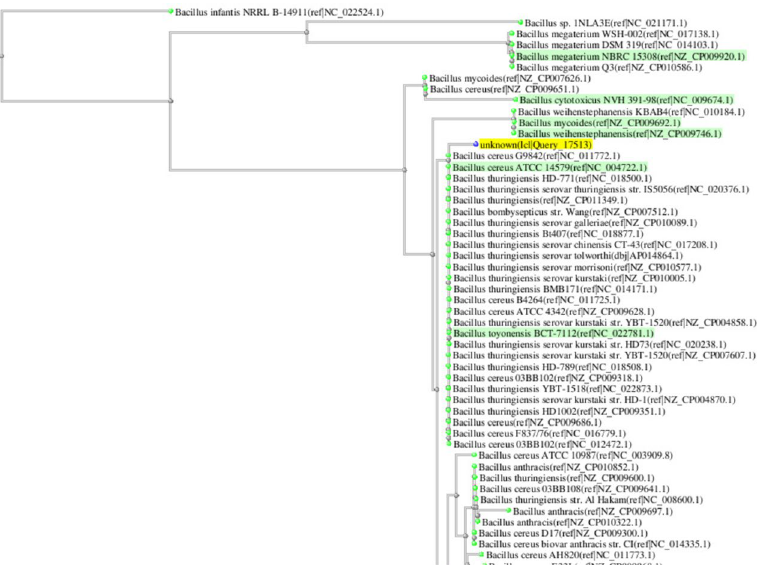
Figure 1. Phylogenetic tree of strain